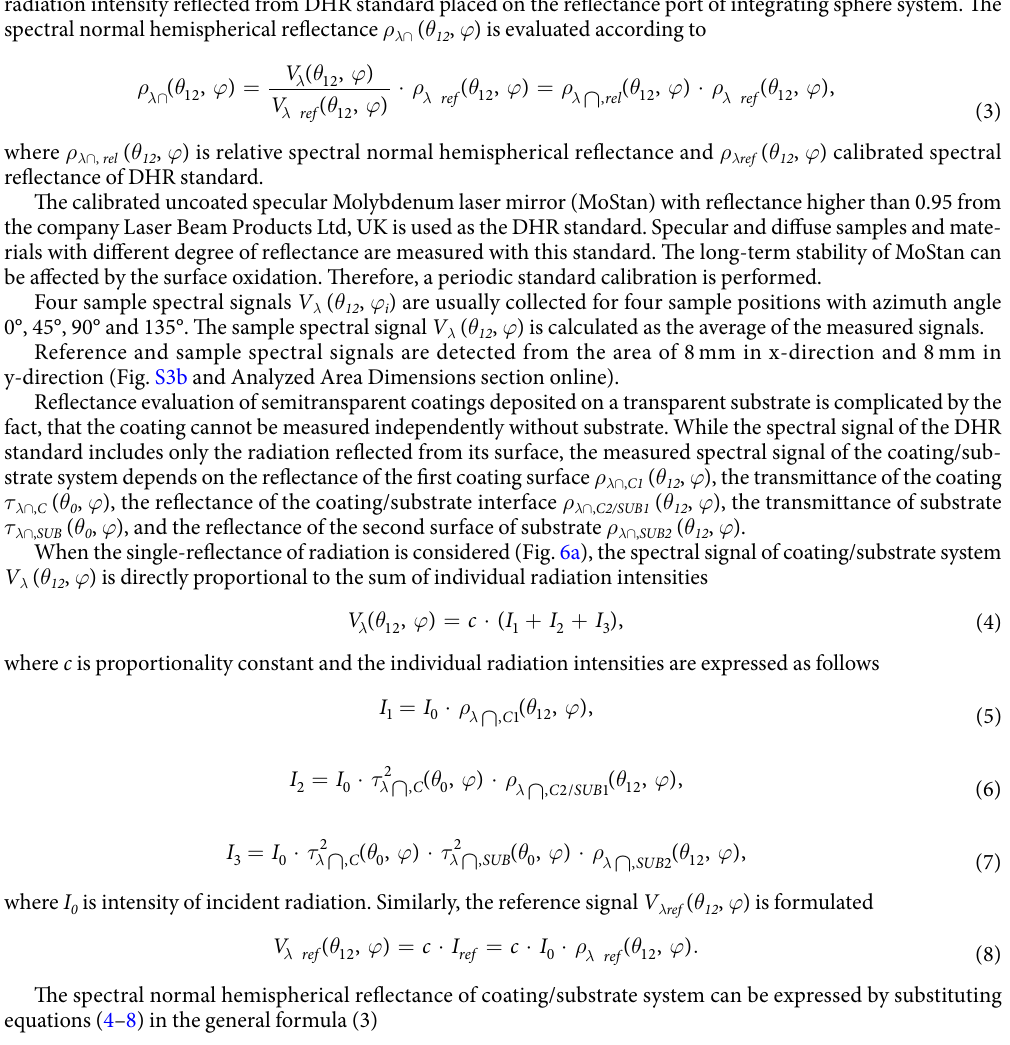
The analyzed area dimensions depend on the thickness of analyzed sample (Fig. S3a and Analyzed Area Dimensions section online). This varies from 19 mm (for sample thickness 0.01 mm) to 22 mm (for sample thick- ness 7 mm).